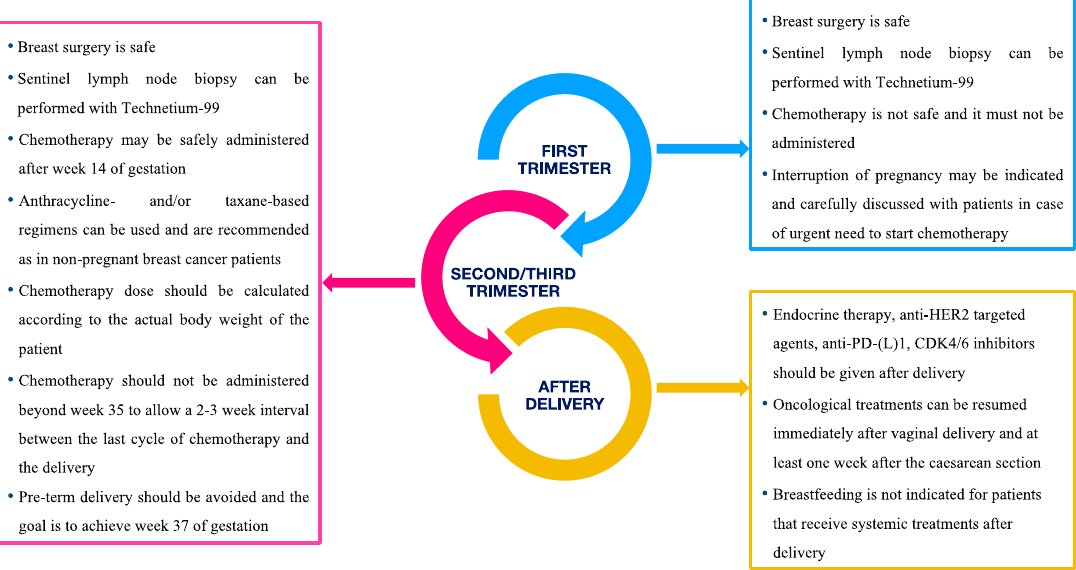
Figure 1. Summary of management’s recommendations according to gestational age or post-partum period.